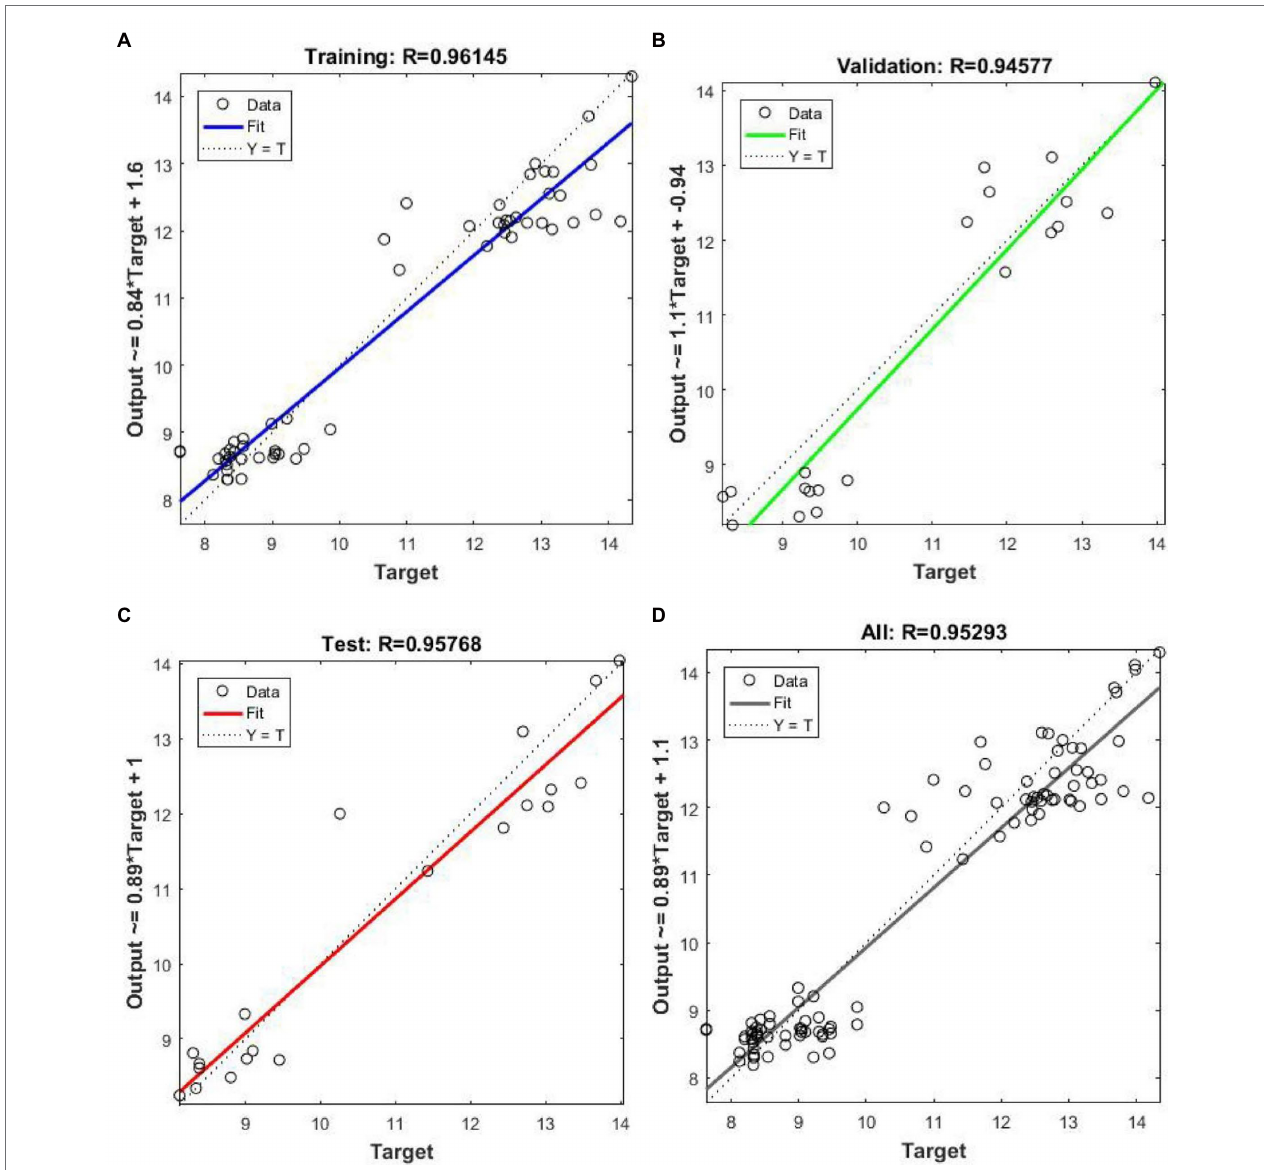
FIGURE 18 | Scatter plot of the detection values and the physicochemical values. (A) Training set, (B) Validation set, (C) Test set, (D) All values.